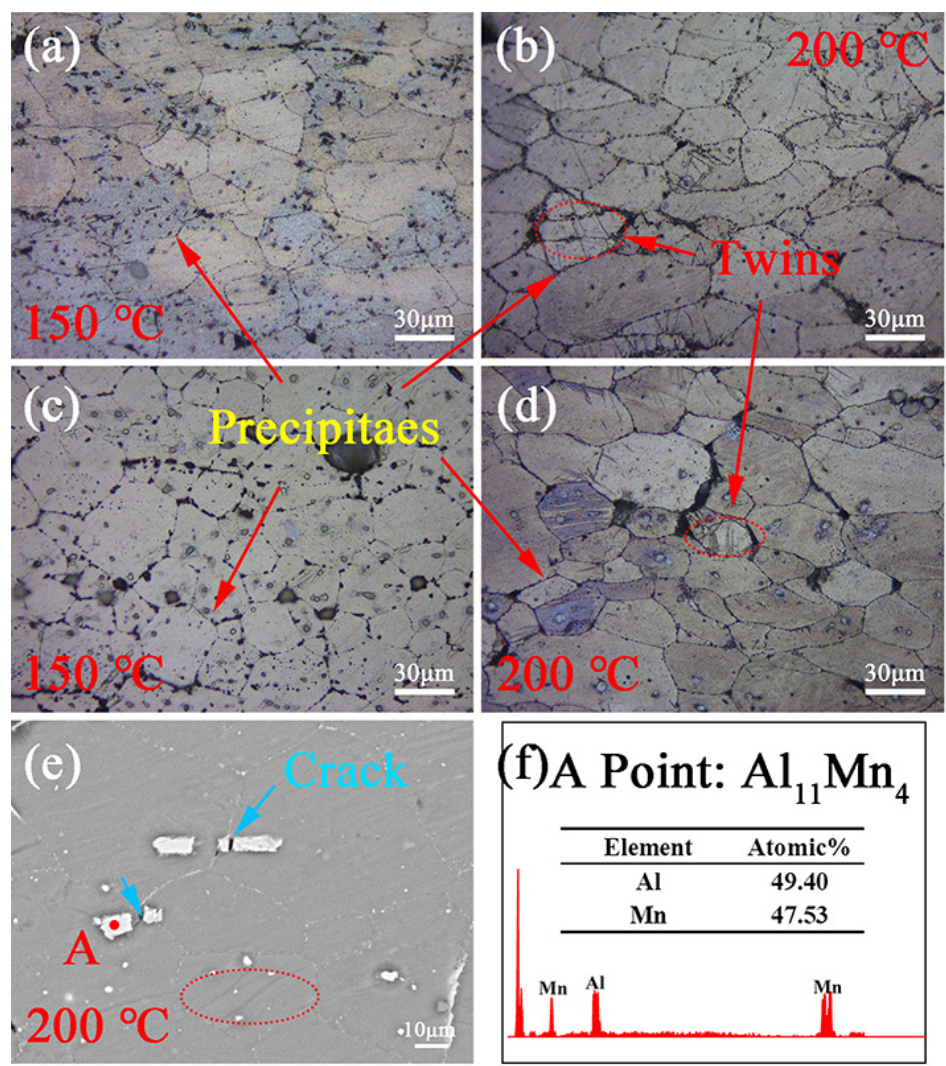
Figure 13. Optical images ( a – d ) and BSE-SEM ( e ) from longitudinal sections adjacent to fracture surface tested at 150 °C ( a , c ) and 200 °C ( b , d , e ) of the double-aged ZTM641-xAl alloys, ( a , b ) x = 0.2, ( c – e ) x = 2, ( f ) corresponding EDS result of the point indicated in ( e ).